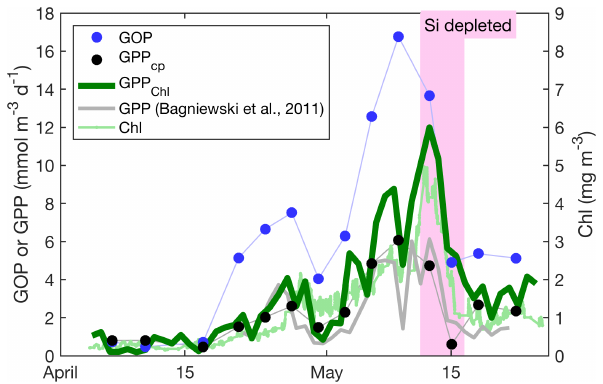
Figure 8. Primary productivity estimates within the daily mini- mum ML. GPP Chl a , GOP, GPP cp , and GPP from Bagniewski et al. (2011), along with ML Chl a . Diel-cycle-based estimates are 3-day means; other productivity estimates are daily, and Chl a is